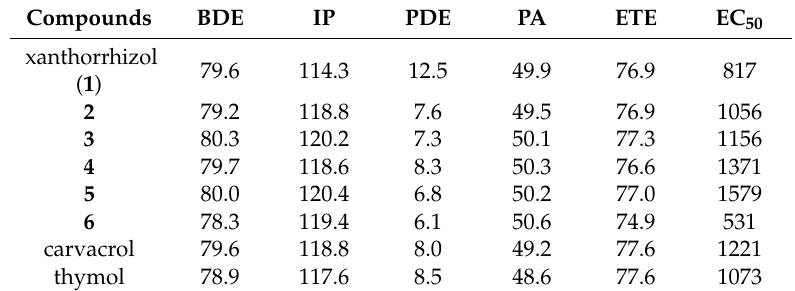
Table 2. Thermodynamic parameters (kcal/mol) in methanol and DPPH radical scavenging ability ( µ M) Compounds